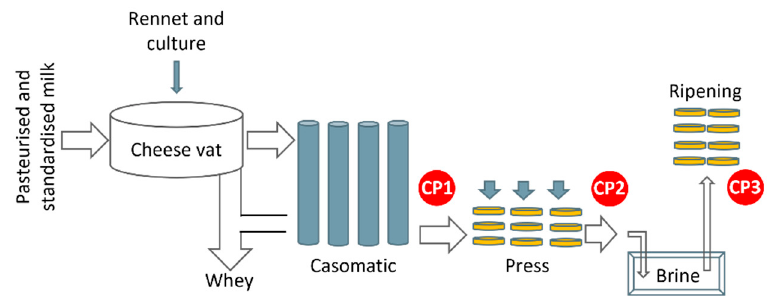
Figure 1. Schematic overview of the cheese production process. Control Points (CP) are marked with red circles. The in-line NIRS sensor was positioned at either CP1 or CP2, while the grab samples were taken at CP3.